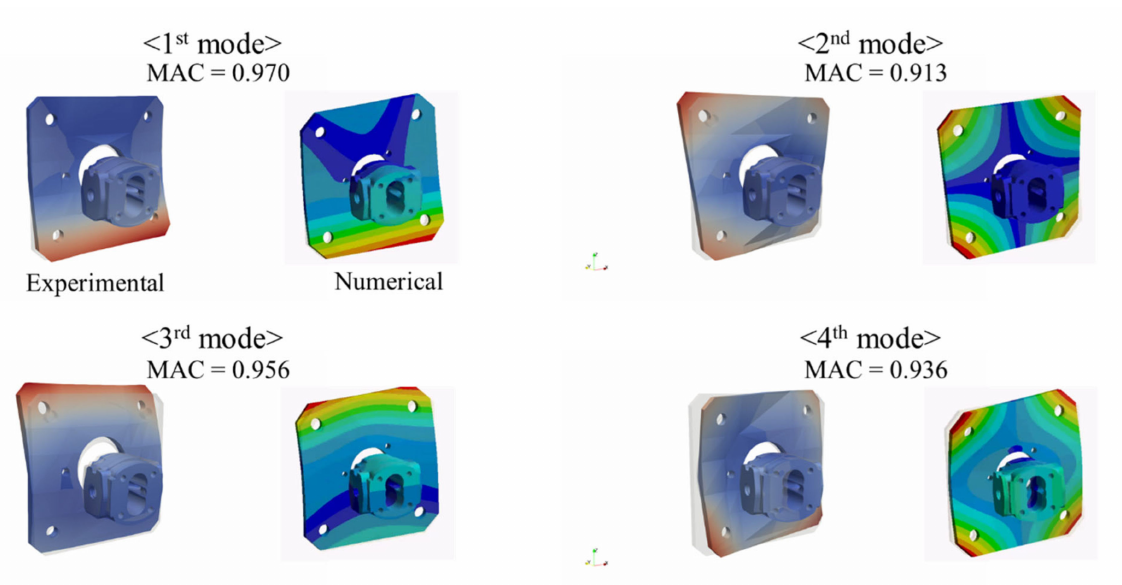
Figure 12. Comparison between experimental mode shapes and numerical mode shapes of the full assembly of the mounting plate and the pump after consideration of the bolted